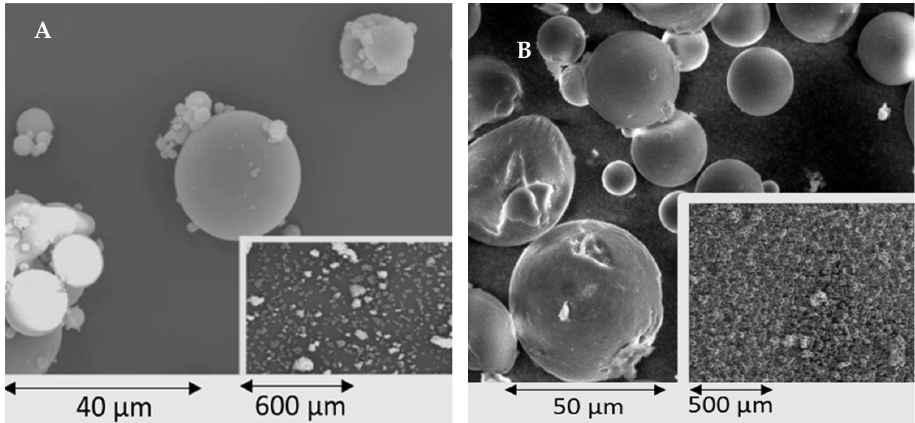
Figure 3. Scanning electron microscopy pictures of Suspension synthesized MIP by Gallegos- Gallegos [31] ( A ) and in this study ( B ).